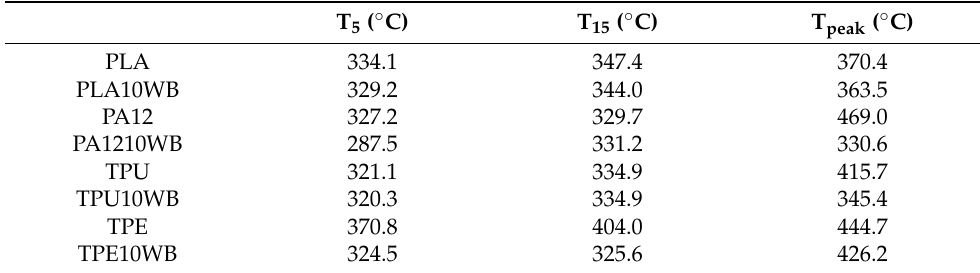
Figure 3. ( a ) Torque values recorded at the steady state during the internal-mixer processing and ( b ) mass melt flow rate (MFR) values of the WB-based samples. Table 2. Thermogravimetric analysis (TGA) of the WB-based